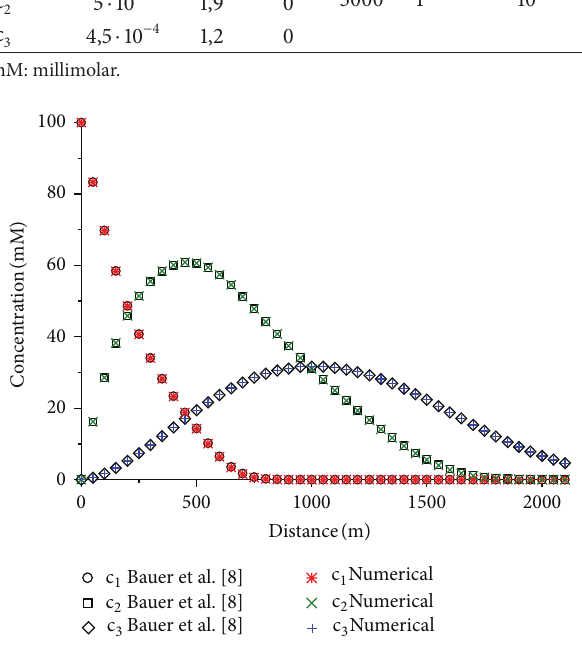
Figure 3: Concentration profiles 𝑐 1 , 𝑐 2 , and 𝑐 3